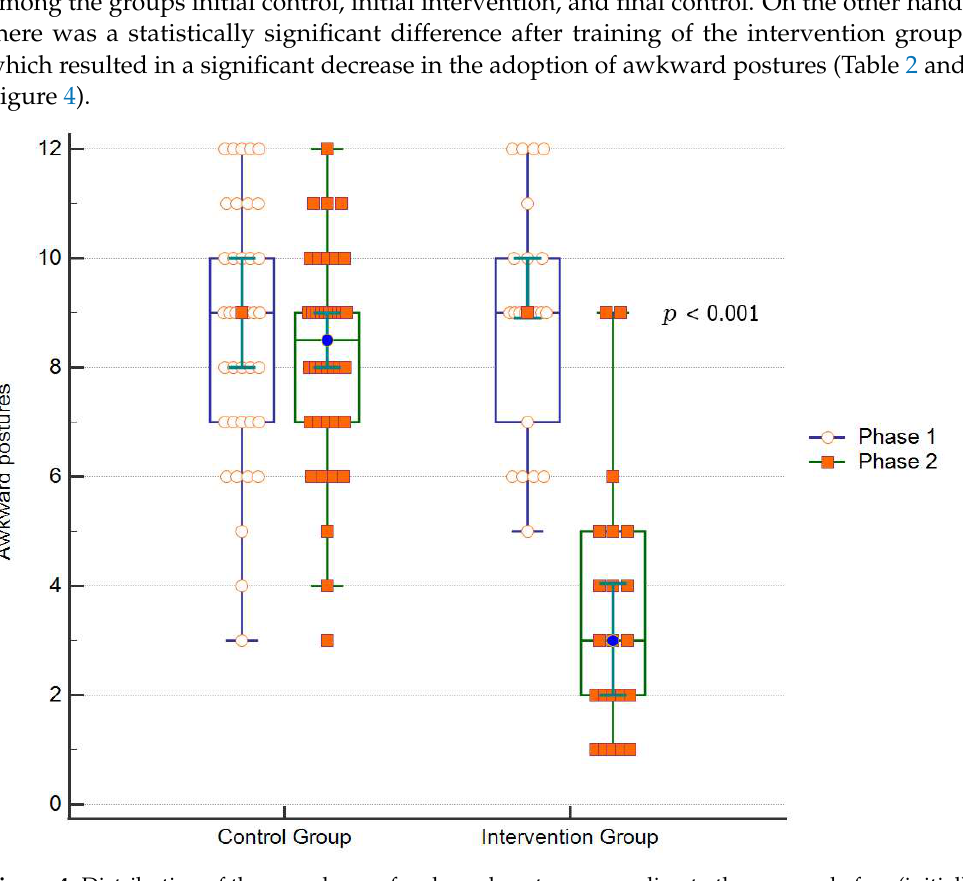
Figure 5. Distribution of the difference between the scores of awkward postures after and before training, according to the groups.